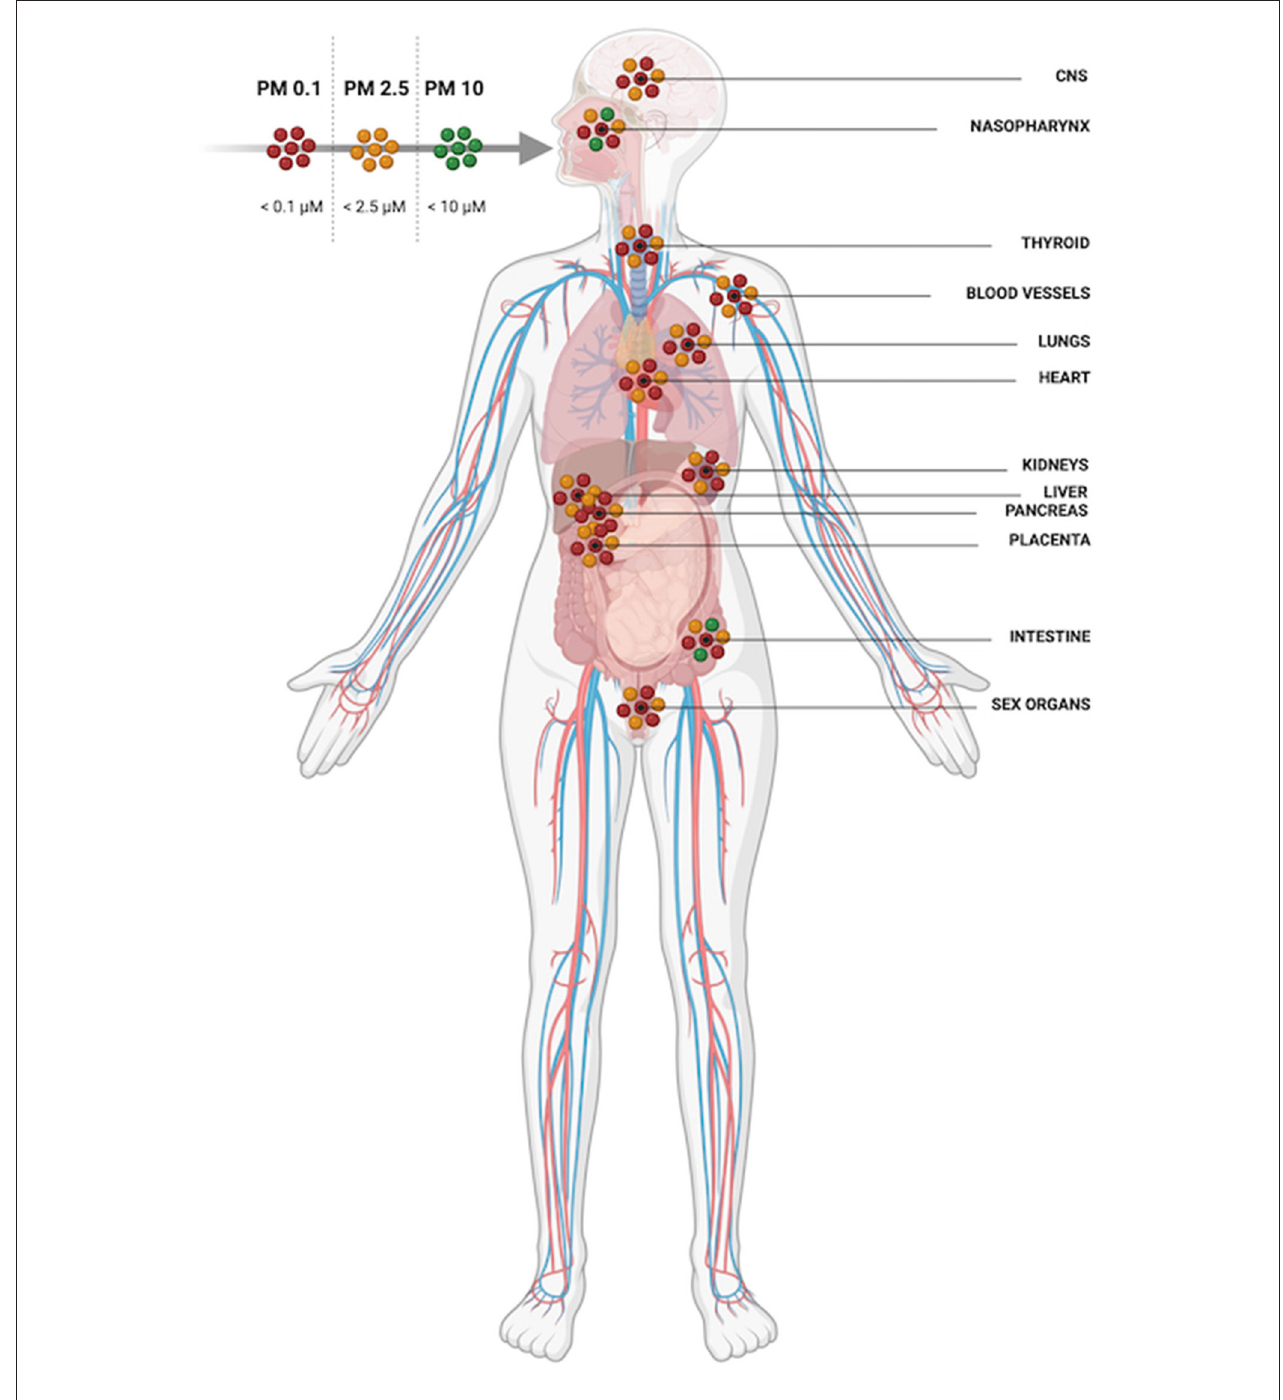
FIGURE 3 | PM 10 is restricted to the upper airway and digestive system whilst PM2.5 and PM0.1 can be inhaled deeply into the lungs, translocate epithelial barriers and gain access to multiple organ systems.